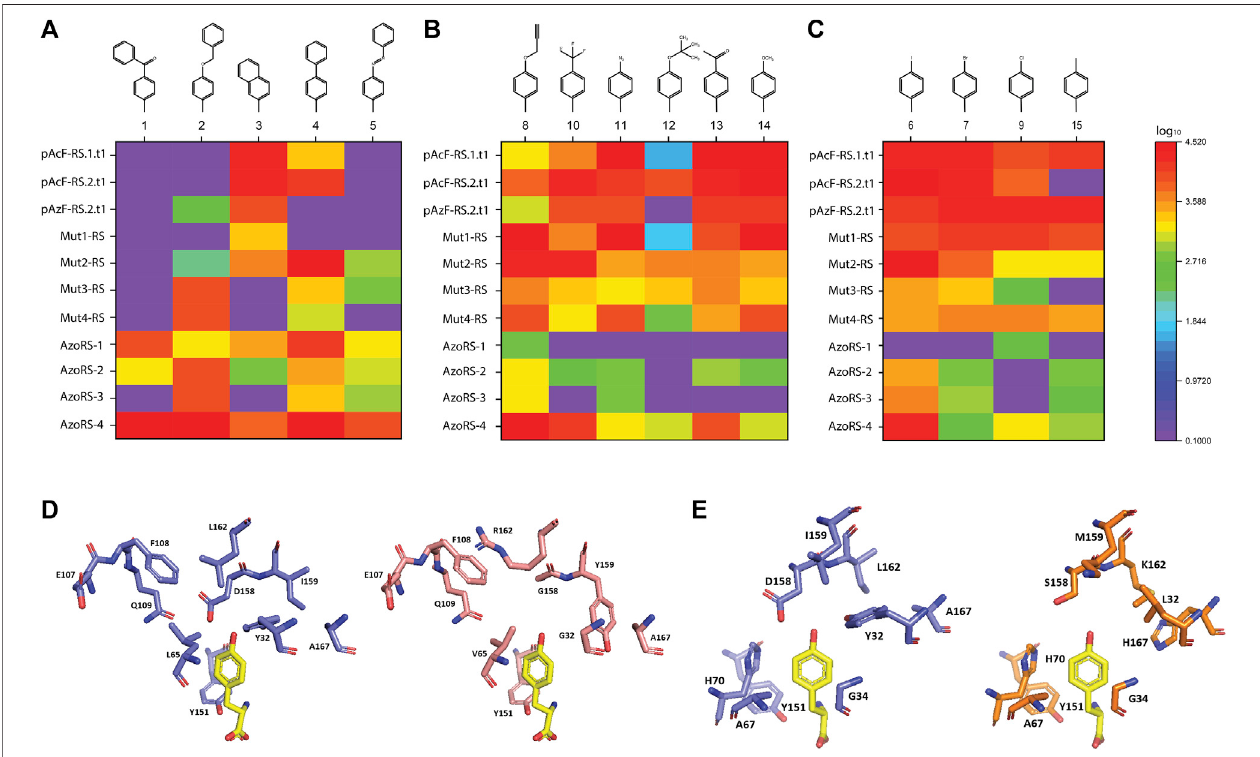
FIGURE 1 | (A – C) Speci fi cities of high-performance aaRS variants for the 15 ncAAs depicted in Supplementary Figure S1 , assessed by their incorporation into the reporter protein ELP(30TAG)-GFP. (D – E) A comparison of the AA-binding pocket, shown in complex with the native cognate AA tyrosine (yellow), of (D) native MjTyrRS(purple)comparedwithAzoRS-4(pink),and (E) nativeMjTyrRS(purple,differentangle)andMut1-RS(orange).Thestructuralmodelsweregenerated(basedon PDB ID: 1J1U) using the PyMOL program (Schrödinger,